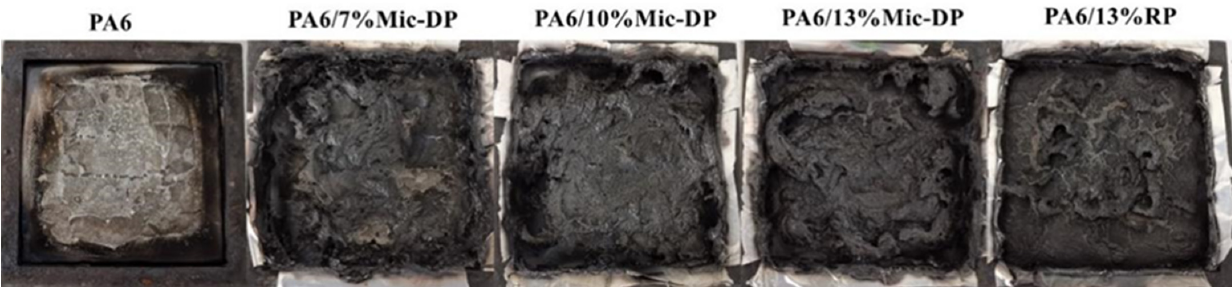
Figure 6. Photographs of residual chars from PA6 samples. The SEM images of residual chars from PA6/13%Mic − DP and PA6/13%RP were shown in Figure 7. For the PA6/13%RP, the residual carbon was more loose, with more holes. For the PA6/13% Mic − DP, the residual chars were more continuous and denser, due to the shell material of Mic − DP, which decomposed from nonflammable gas and provided the carbon source. Figure 7. SEM images of residual chars from PA6 samples. Generally, the graphitic structure of the residual chars can be investigated by Raman spectroscopy. The Raman spectra of the residual chars of PA6/13%Mic − DP and PA6/13%RP were shown in Figure 8. The D and G bands appeared at 1364 and 1614 cm − 1 , which represent the two structures of disordered graphite and graphite, respectively. This is related to the vibration of carbon atoms in graphite layers. The integral ratio of the band area (I D /I G ) reflected the graphitization degree of the residue chars. The I D /I G of PA6/13%Mic − DP (2.3) was lower than PA6/13%RP (2.44), indicating the higher graphiti- zation degree of the residual char of PA6/13%Mic − DP, which demonstrated that the car- bon layer of PA6/13%Mic − DP was more regular and continuous.